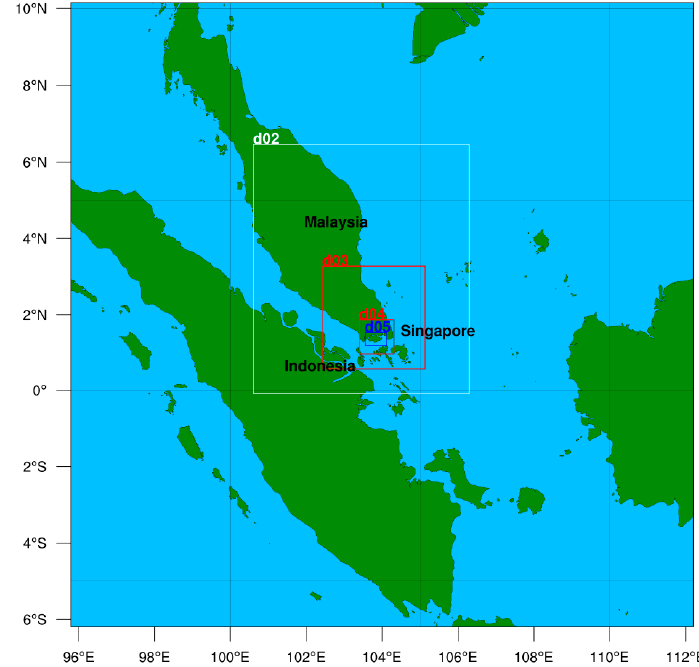
Figure 1. Location of Singapore. Configuration from weather research and forecasting (WRF) model simulations (Source: Mughal [24]).